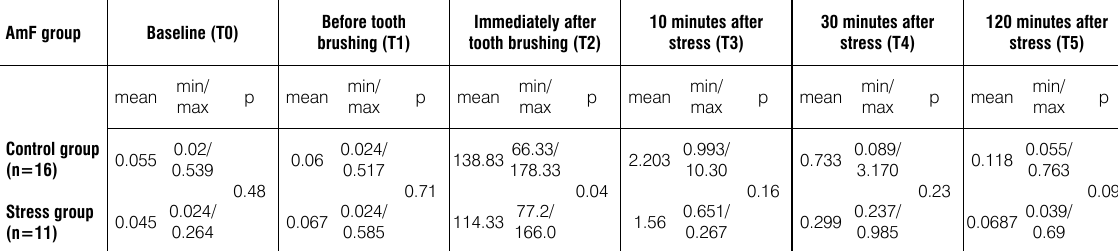
Table 1. Saliva fluoride concentration in the AmF control and AmF stress groups.